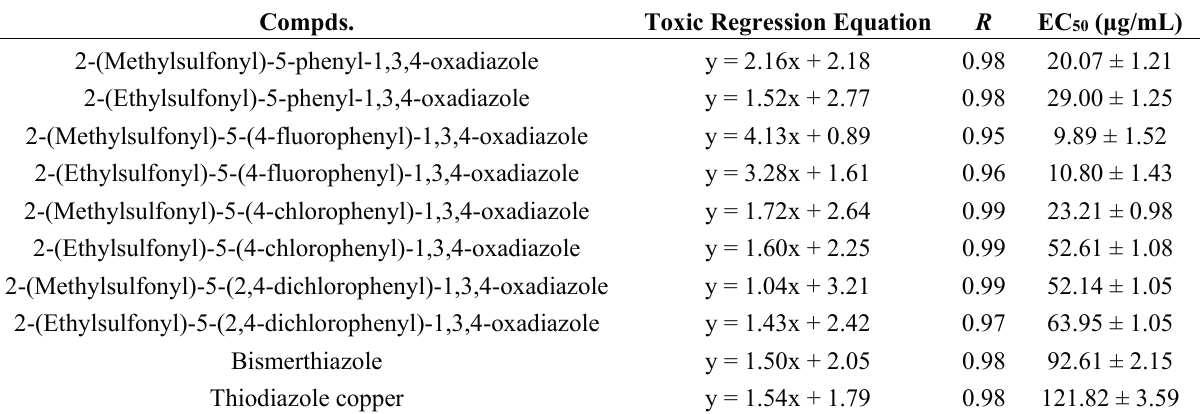
Table 1. Antibacterial activities against Xanthomonas oryzae pv. oryzae of the title compounds.